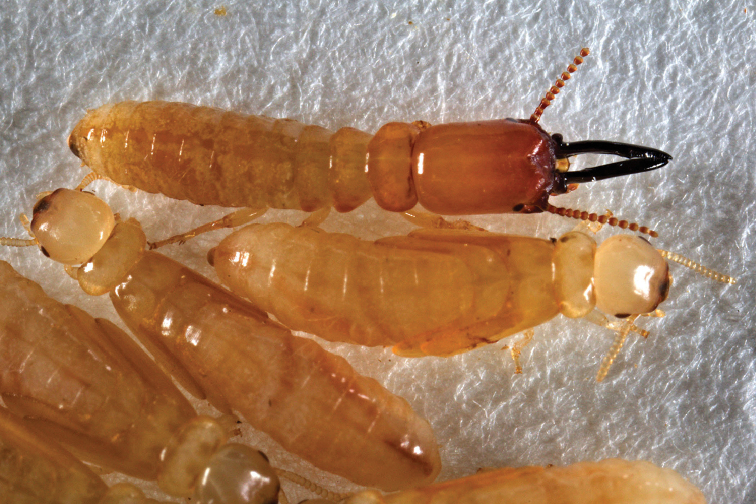
Live habitus of soldier and brachypterous nymphs of Roisinitermesebogoensis gen.et sp. n.